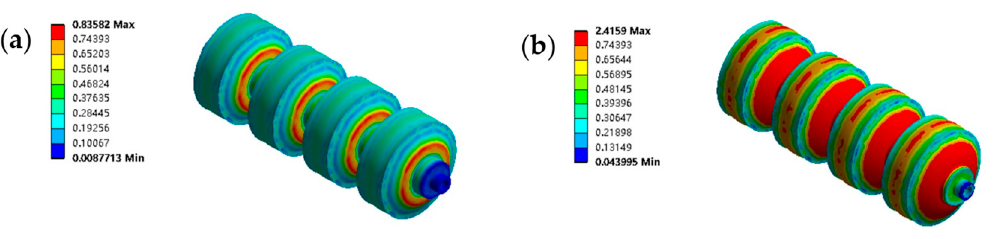
Figure 14. Design revisited for the auxetic cavity structure. ( a ) The von Mises stress of the single- channeled actuator with the auxetic cavity structure under 30 KPa air pressure. ( b ) The von Mises stress of the double-channeled actuator with the auxetic cavity structure under 100 KPa air pressure.